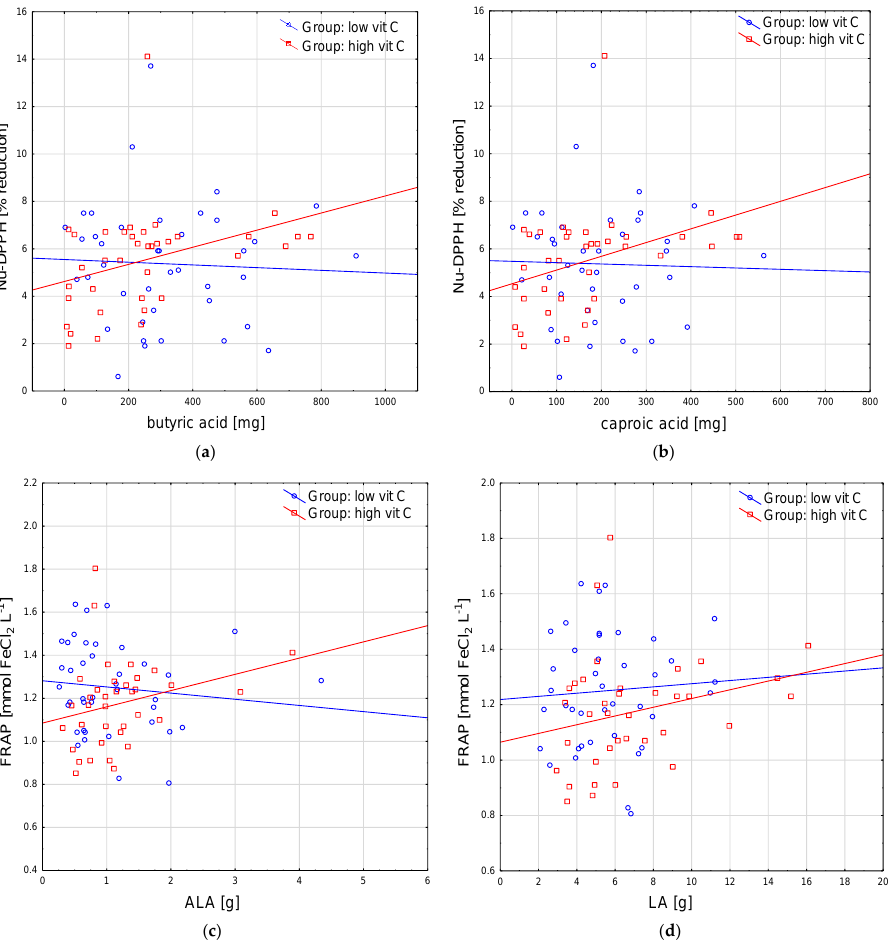
Figure 1. Selected correlations between plasma antioxidant parameters and short-chain fatty acids: ( a ) Nu-DPPH and butyric acid; ( b ) Nu-DPPH and caproic acid. Correlations between plasma anti- oxidant parameters with essential PUFAs: ( c ) FRAP and ALA; ( d ) FRAP and LA. ALA, alpha-lino- lenic acid; FRAP, ferric reducing ability of plasma; LA, linoleic acid; Nu-DPPH, non-urate 2.2-di- phenyl-1-picryl-hydrazyl test of plasma.